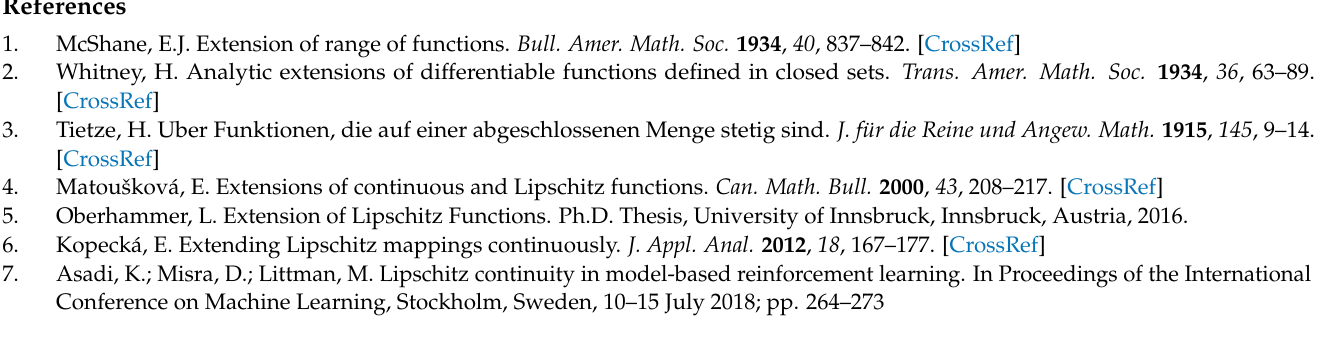
Figure 10. Extension of the function f ( x , y ) = x · cos ( 10 y ) defined on C = { ( x , y ) ∈ R 2 : 1 max ( | x | , | y | ) ≤ 1 } using the 2-average-slope-minimizing